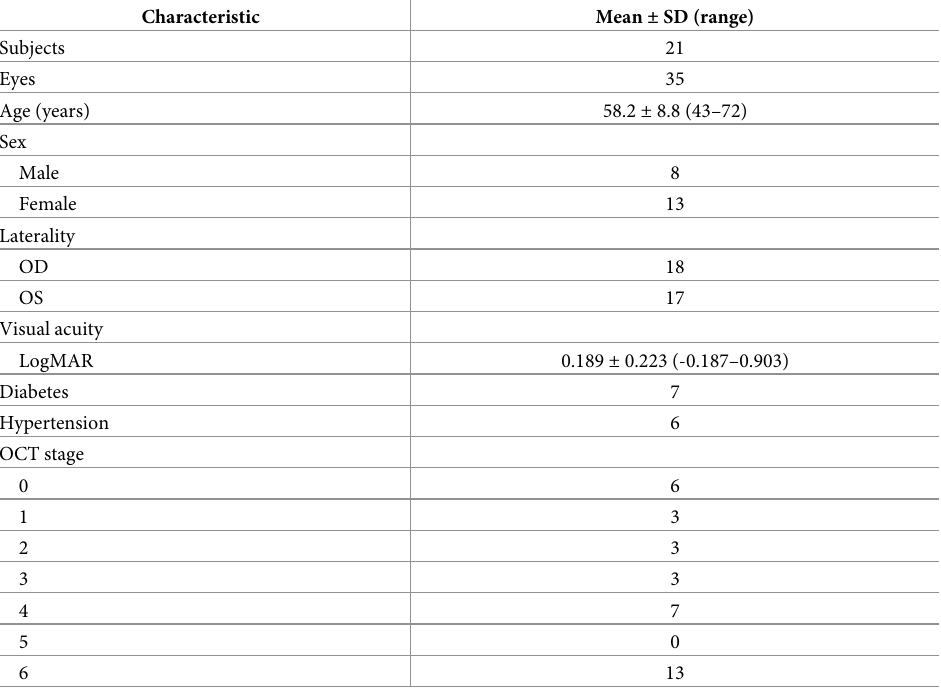
Table 1. Demographics, clinical characteristics, and MacTel staging of study